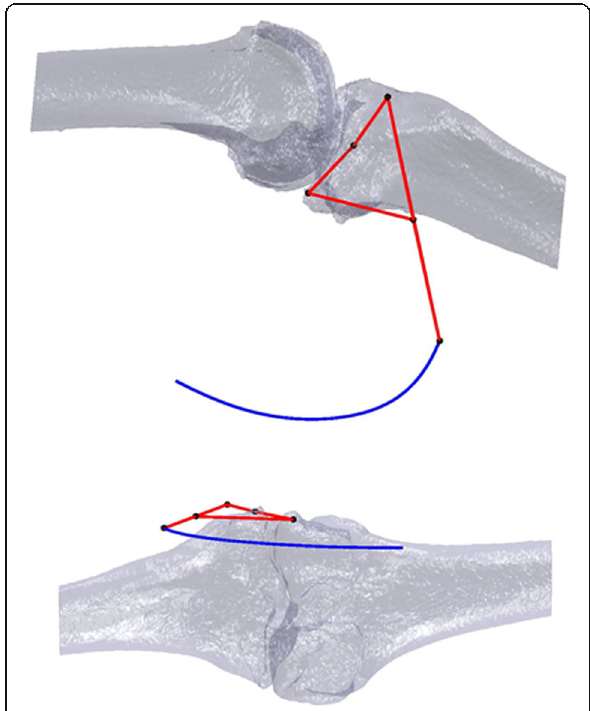
Fig. 5 Illustration of the computed four-bar mechanism (red) for the patient ’ s 3D knee model (grey) in the plane of the measured tibia ’ s positions, with the trajectory of the coupler point of the four-bar (blue)